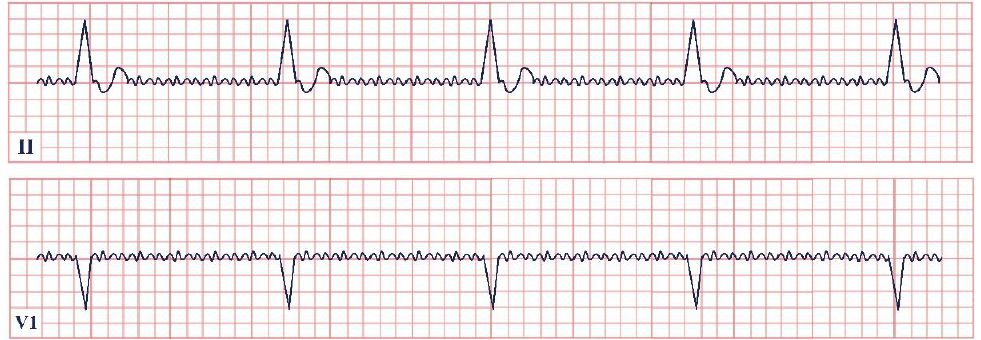
Figure 9. Electrocardiogram aspect in Frederick ’ s